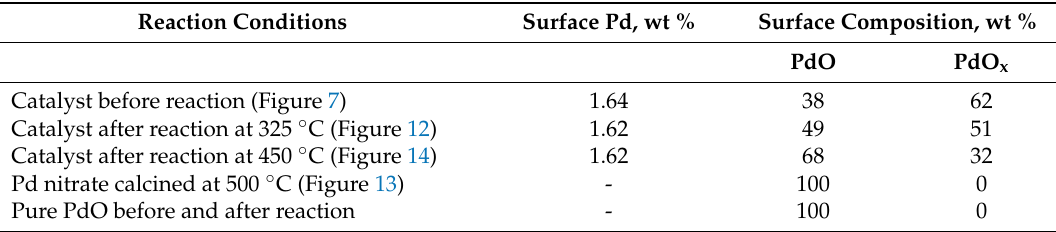
Table 4. Change in surface composition with reaction